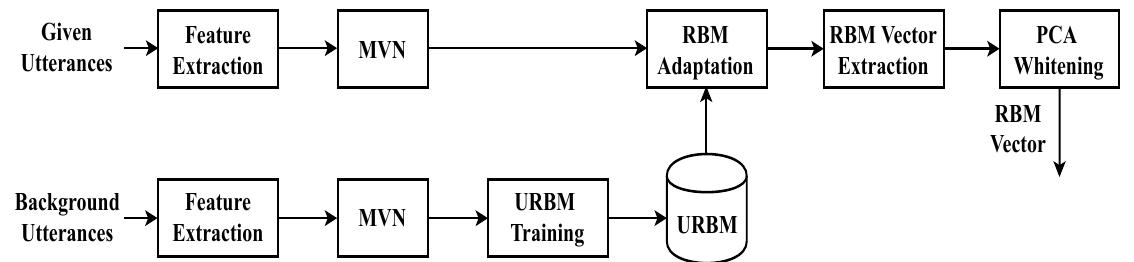
Figure 1. Block diagram showing different stages of the Resricted Botlzmann Machine (RBM) vector